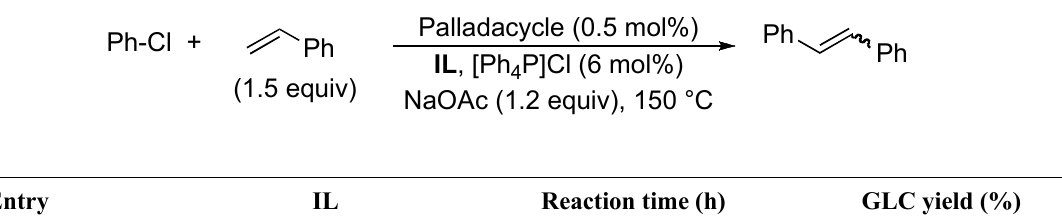
Table 4. Palladacycle-mediate Heck reaction in